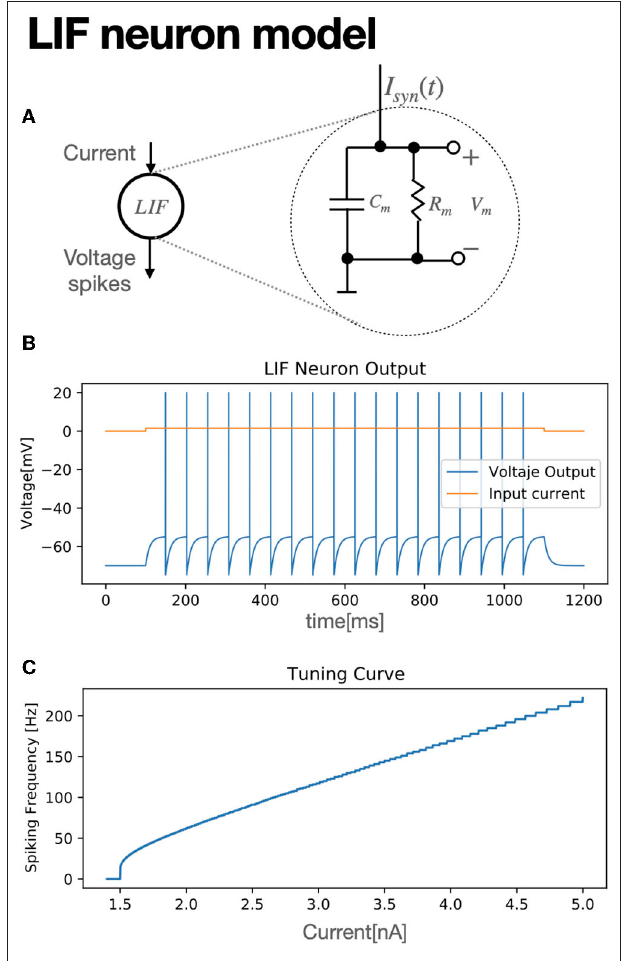
FIGURE 1 | LIF model (A) diagram of a spiking LIF neuron. (B) Spiking activity for a LIF neuron with I syn = 1.51 nA . (C) Tuning curve of the neuron model. Neuron parameters are in Table 1 .